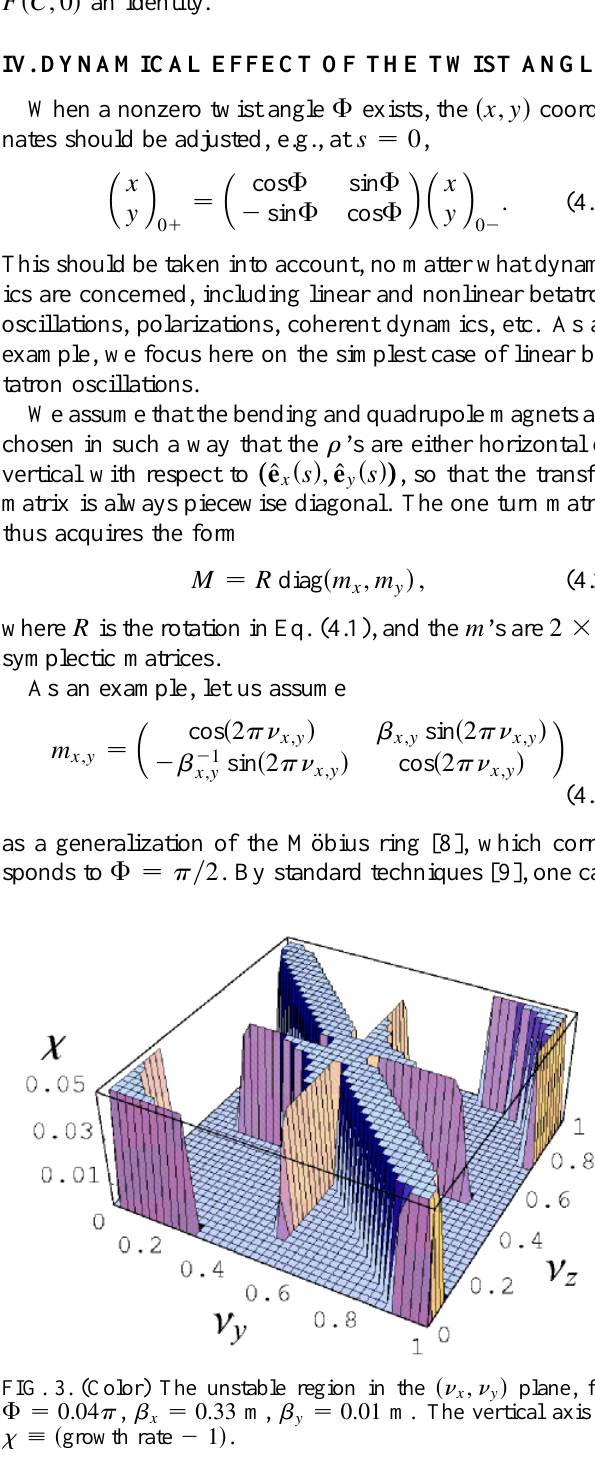
Fig. 3, for F (cid:1) 0.04 p , b x (cid:1) 0.33 m, and b y (cid:1) 0.01